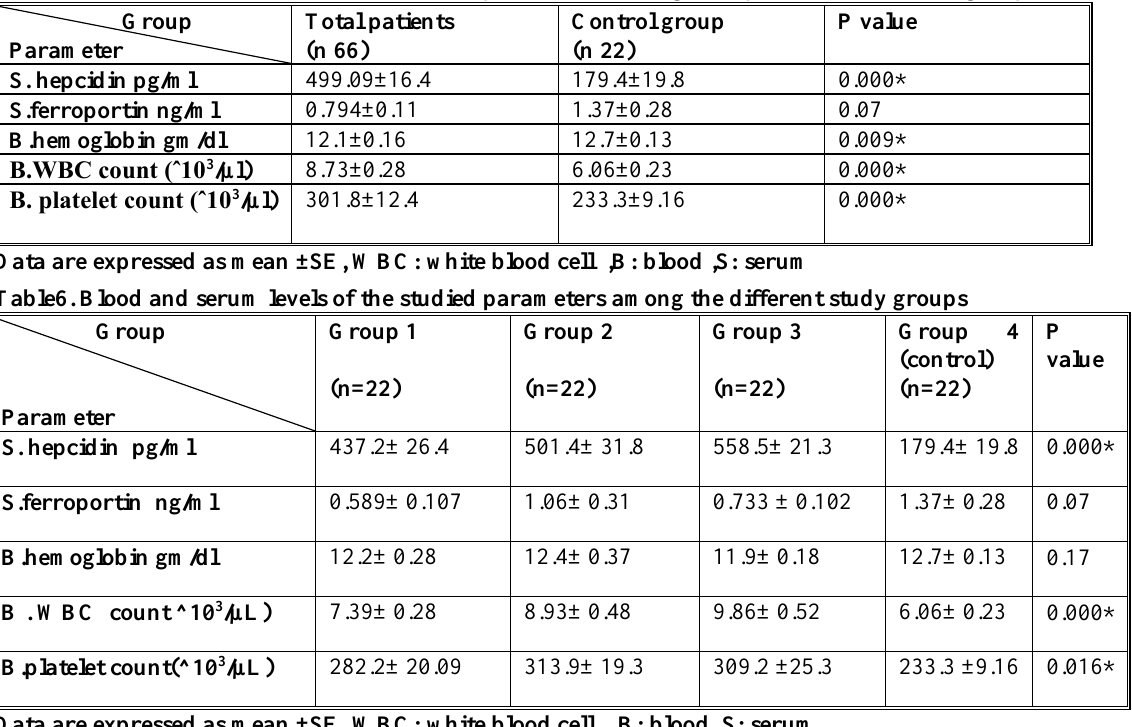
Table5. Blood and serum levels of the studied parameters among total patients and control groups Group Parameter